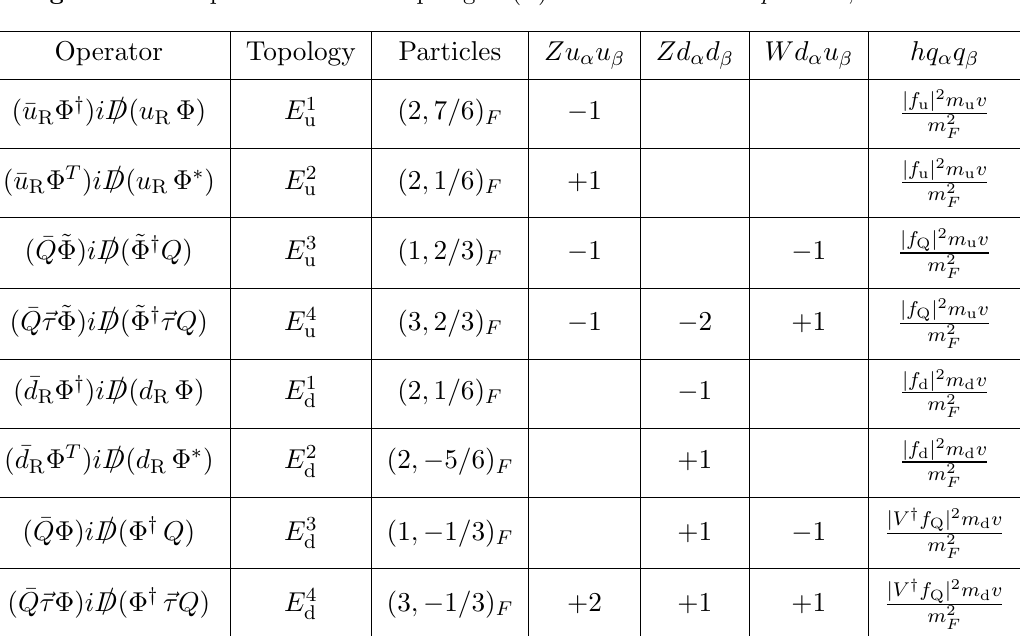
Figure 3 . Examples of tree-level topologies (E) of the Derivative operators , see table 3.